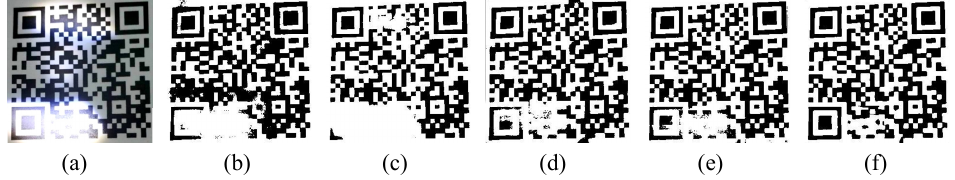
Figure 16. The original image and experimental results of different algorithms: ( a ) Original image; ( b ) Sauvola’s algorithm [6]; ( c ) Yao’s algorithm [18]; ( d ) Di’s algorithm [8]; ( e ) Chen’s algorithm [13]; ( f ) Proposed method. Figure 17. The original image and experimental results of different algorithms: ( a ) Original image; ( b ) Sauvola’s algorithm; ( c ) Yao’s algorithm; ( d ) Di’s algorithm; ( e ) Chen’s algorithm; ( f ) Proposed method.